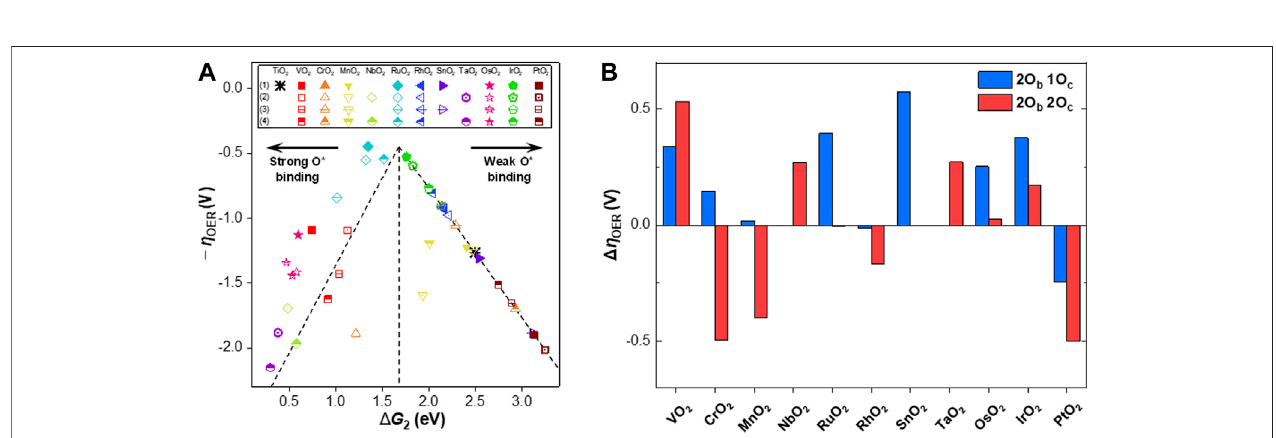
FIGURE3|(A) Volcano plotforthenegativeoverpotentialoftheOER (− η OER ) asafunctionof Δ G 2 .Thenumbersintheinsetindicateeach surface:1)2O b ofMO 2 , 2) 2O b 2O c ofMO 2 , 3) 2O b of MO 2 /TiO 2 , and 4) 2O b 2O c of MO 2 /TiO 2 . (cf. Supplementary Table S2 ). (B) Difference between the overpotentials of MO 2 and MO 2 /TiO 2 [ Δ η (cid:1) η ( MO / TiO ) − η ( MO )] . A positive value of Δ η 2 2 2 OER OER OER OER indicates the decrease in the OER activity and a negative